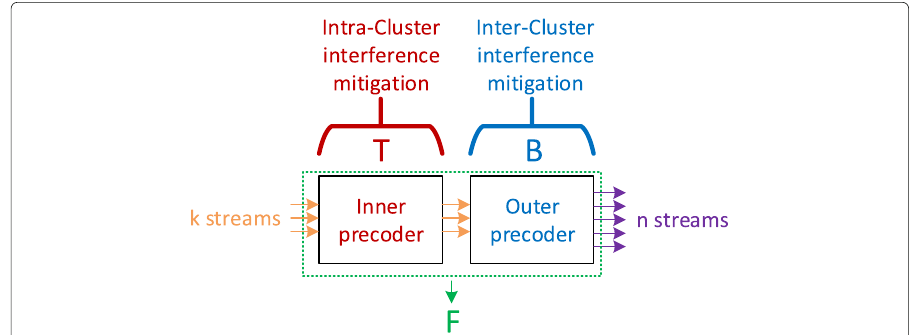
Fig. 2 Two-level precoding structure. The outer precoder B operates on-board the satellite, whereas the inner precoder T is on the